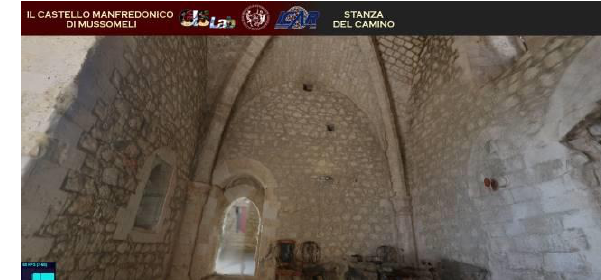
Figure 9. The virtual indoor navigation inside the model of the